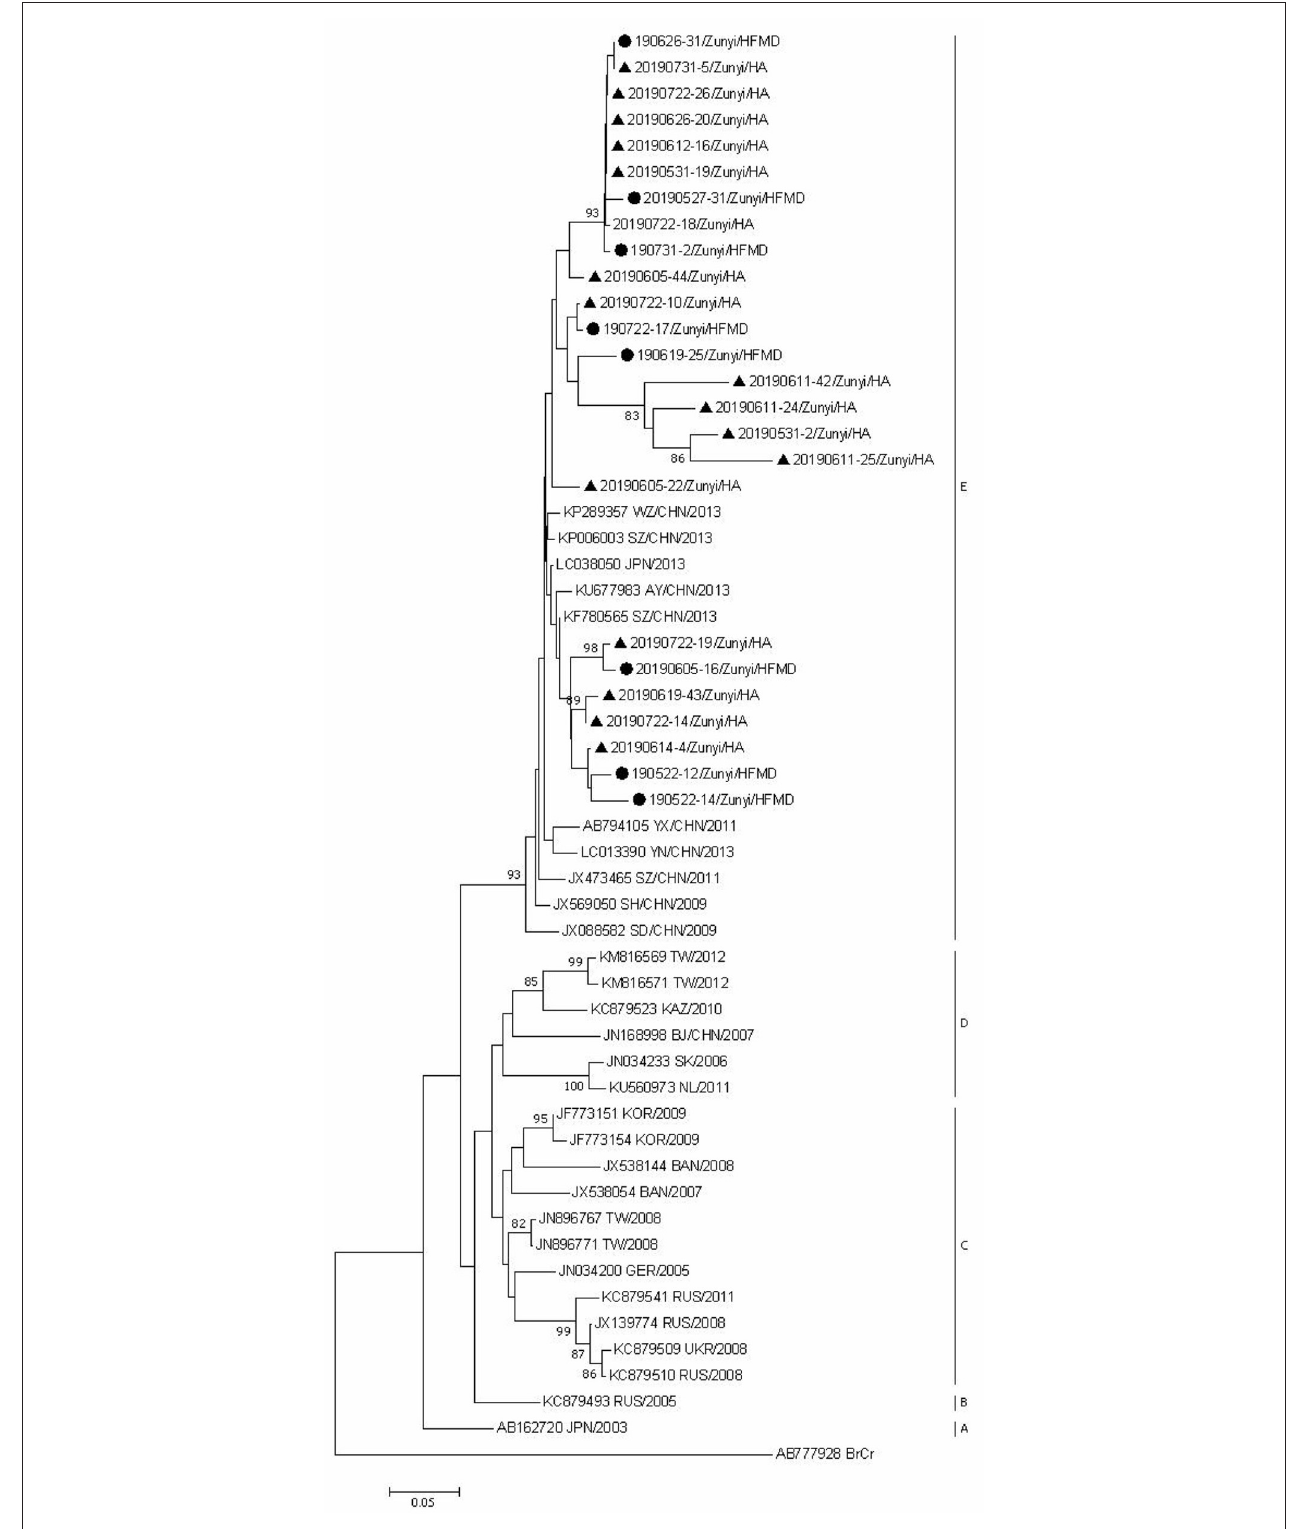
FIGURE 6 | Phylogenetic analysis of CVA2 based on partial VP1 gene sequence. Strains identified from HFMD are marked by circle, and those identified from HA are marked by triangle.